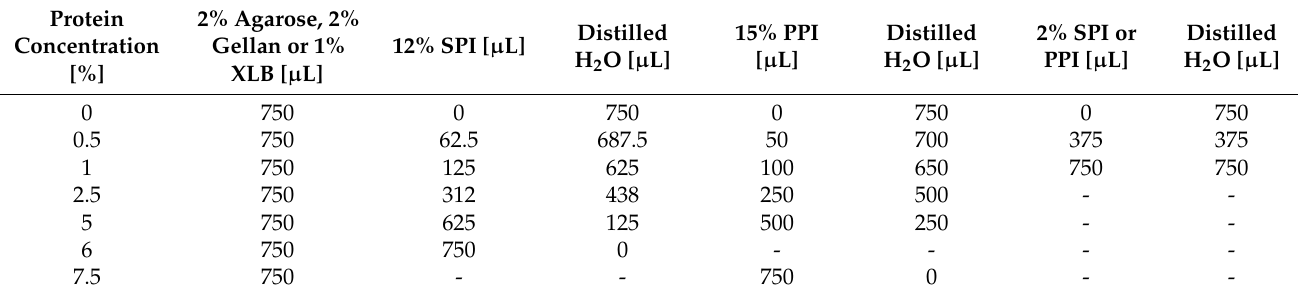
Table 3. Mixing ratios of agarose, gellan and XLB hydrogels with different protein concentrations of SPI and